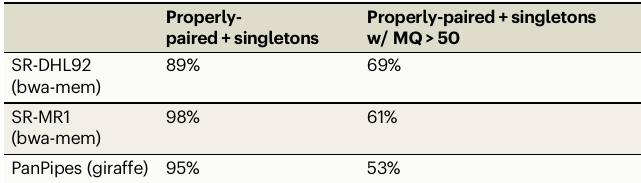
Table 2 | Percent of aligned skim-seq reads across all RIL samples using assorted methods Properly-